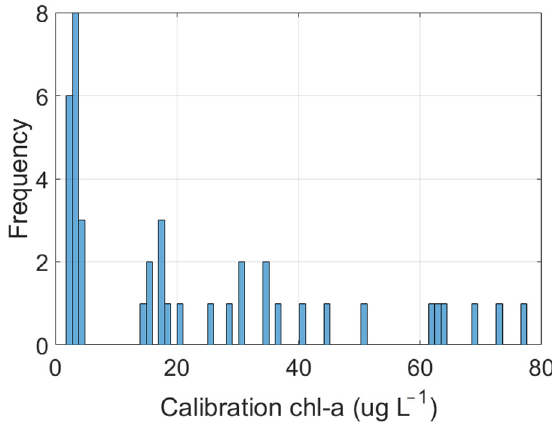
Figure 3. Histogram of the calibration dataset (N = 41).